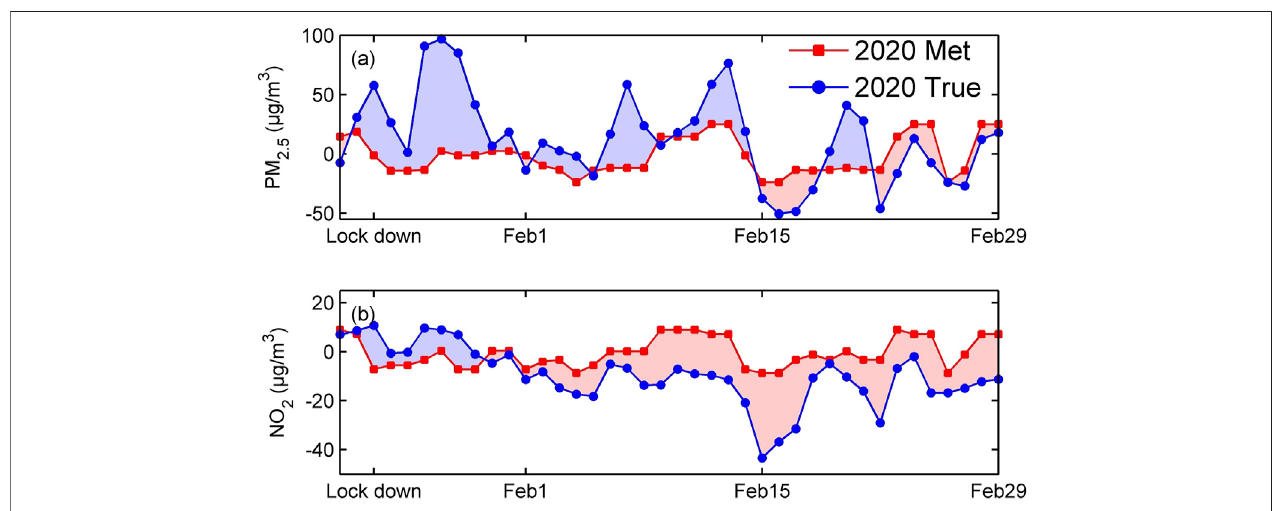
FIGURE 7 | Changes in PM 2.5 (A) and NO 2 (B) concentrations driven by the lockdown. The red (blue) area shows the decreasing (increasing) concentrations. For the lockdown period, Met is de fi ned as the residuals from the corresponding T i mean in climatology.